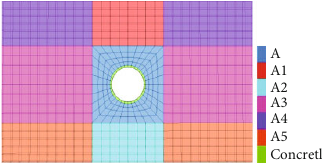
Figure 12: Model diagram after lining support.